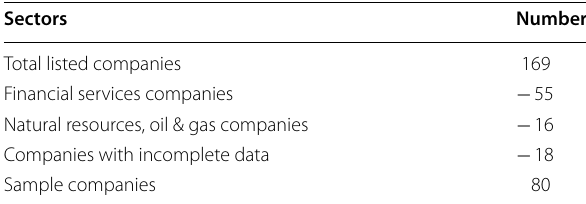
Table 1 Final sample. Source : Researcher’s Computation